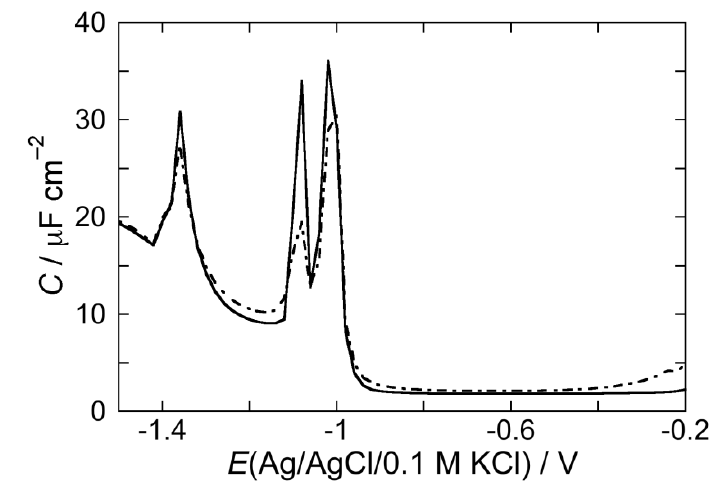
Figure 4. AC voltammogram at a DOPC SAM in a pH 7 buffer solution of 0.1 M in the 2 μg/mL CSF114 after a single EIS scan (dash-dotted curve). Frequency = 75